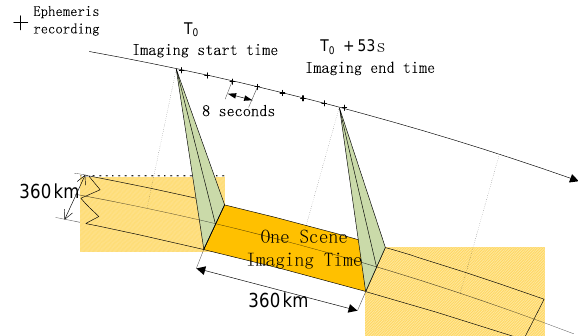
Figure 1. The illustration of ephemeris information recording frequency of HJ-1A/1B Example of a figure caption.